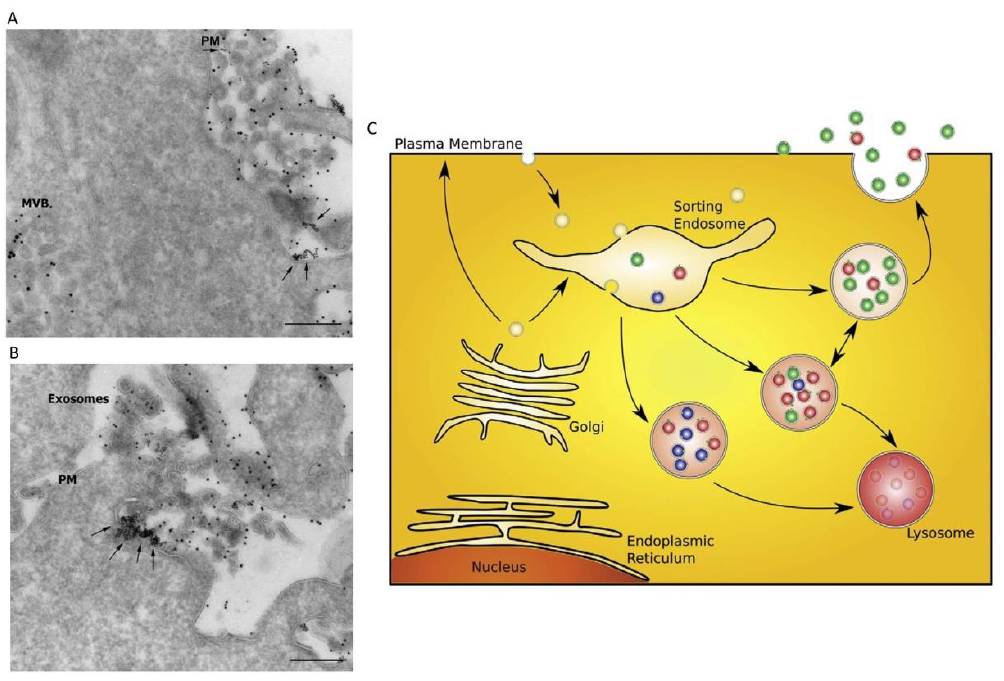
Figure 1. Release of exosomes (EXOs) and a sorting model. ( A , B ) Release of EXOs upon exocytic fusion of multivesicular bodies (MVBs) with the plasma membrane; arrows indicate the fusion profile. PM: plasma membrane; MVB: multivesicular body. Scale bars: 200 nm. ( C ) A proposed model for sorting of cargo into different MVB subpopulations. Different hypothetical MVB subclasses with distinct populations of intraluminal vesicles (red, green, and blue) are shown. Whether the MVBs contain a mixture of different intraluminal vesicles as depicted in the figure is not known. Sorting of cargo may already start within the biosynthetic pathway, at the plasma membrane, or within an endosomal compartment. Modified from Reference [1].